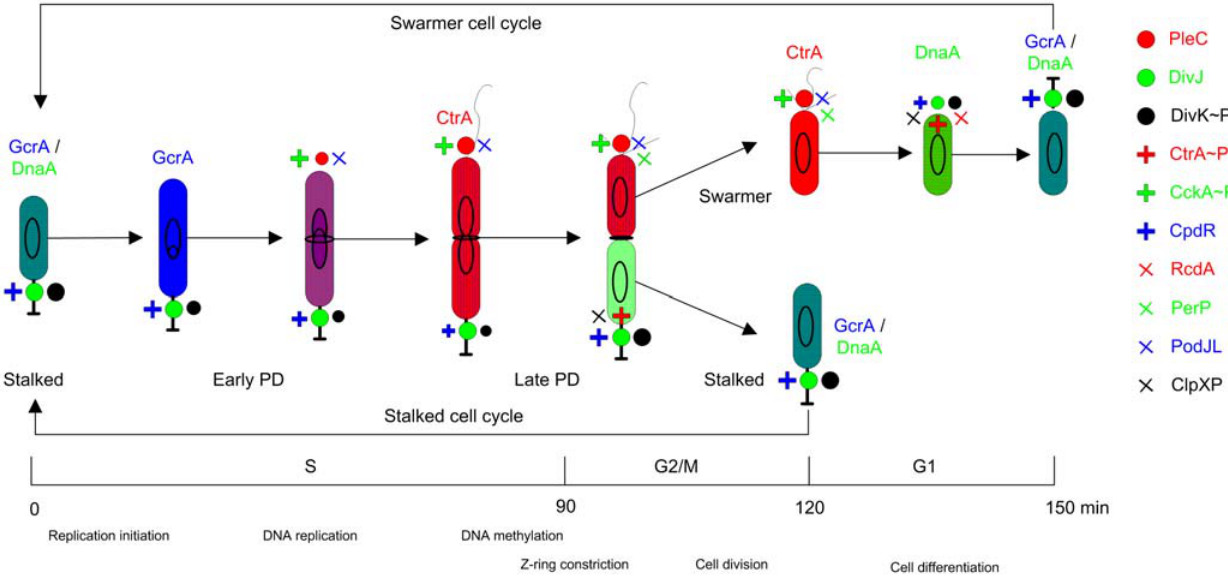
Figure 1. Physiology of the cell division cycle in Caulobactercrescentus. Three cell cycle phases can be distinguished (from the left to the right): a DNA synthesis (S) phase that takes approximately 90 min, a cell division (G2/M) phase, lasting approximately 30 min, that culminates in the separation of mother (stalked) and daughter (swarmer) cells, and a growth and differentiation (G1-like) phase of the swarmer cell that lasts approximately 30 min. The color scheme denotes protein variations through the cell division cycle: GcrA (blue), CtrA (red), DnaA (green). The h -like structure denotes replicating DNA. The ring in the middle of the cell indicates Z-ring assembly and constriction, leading to cell separation (cytokinesis). Symbols of different shapes at the two cell poles denote localization of proteins. Their identities are listed at the right of this figure. PD, predivisional. At the bottom, the time scale and important cell cycle-related physiological events are indicated.